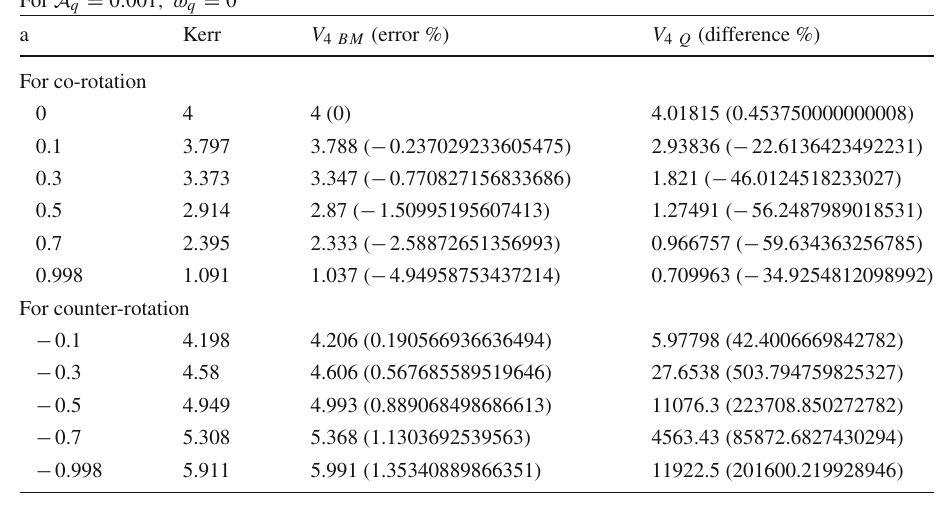
PNPs for very low DE effect of a BH embedded in